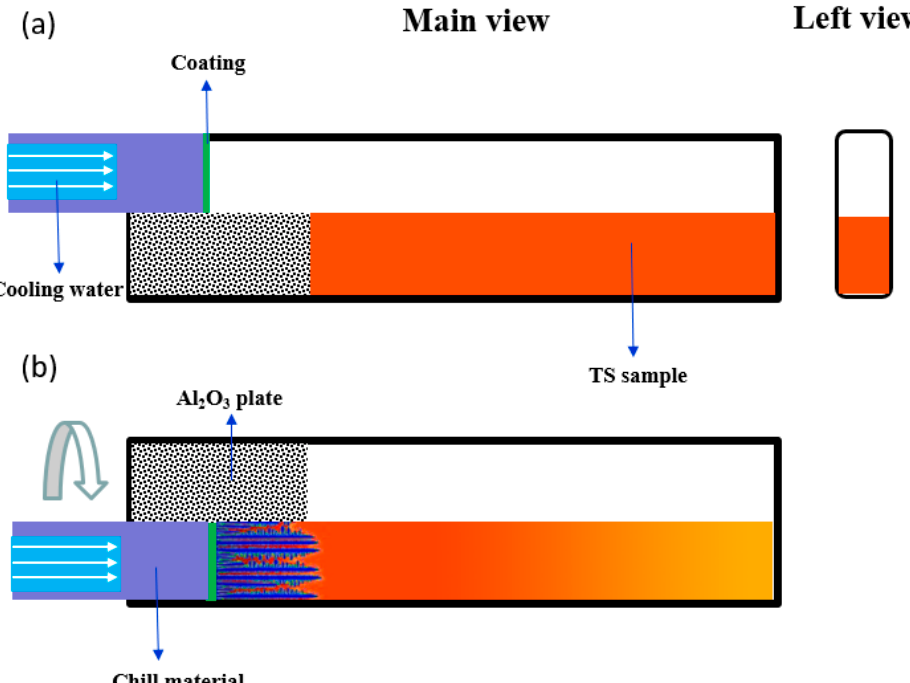
Figure 3. Schematic diagram of the crucible and flipping sample in situ, adapted from [16], with permission from Honggang Zhong, 2019: ( a ) the steel, which separated from chilled material by Al 2 O 3 porcelain beads, was melted in the crucible; ( b ) the steel liquid was poured and contacted the chilled material by the crucible flipped 180 degrees in 1 s.